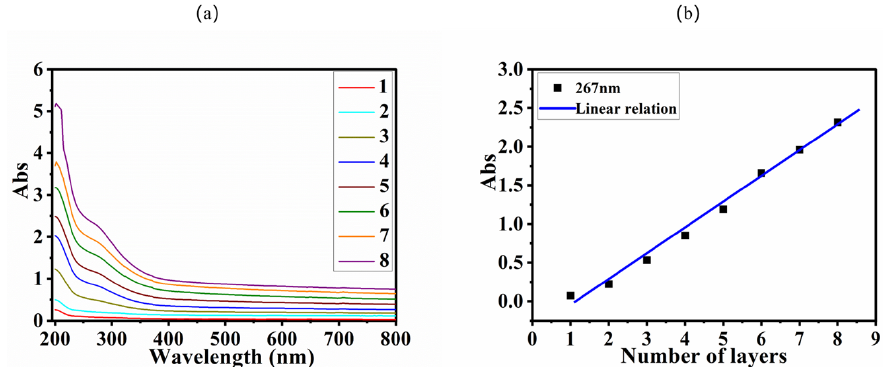
Figure 3. UV-vis spectra of the film (Cu 4 P 4 W 30 /PDDA-GO) 1–8 on quartz sheet ( a ) and the relationship between the absorbance of the characteristic absorption bands at 267 nm and the layer number of the film ( b ). The black square corresponds the absorbance per layer number and the blue line corresponds the fitted linear relationship.